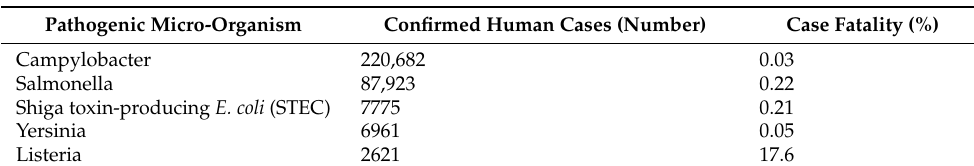
Table 1. Confirmed human cases associated with foodborne pathogens in EU member states and associated countries in 2019 [19].